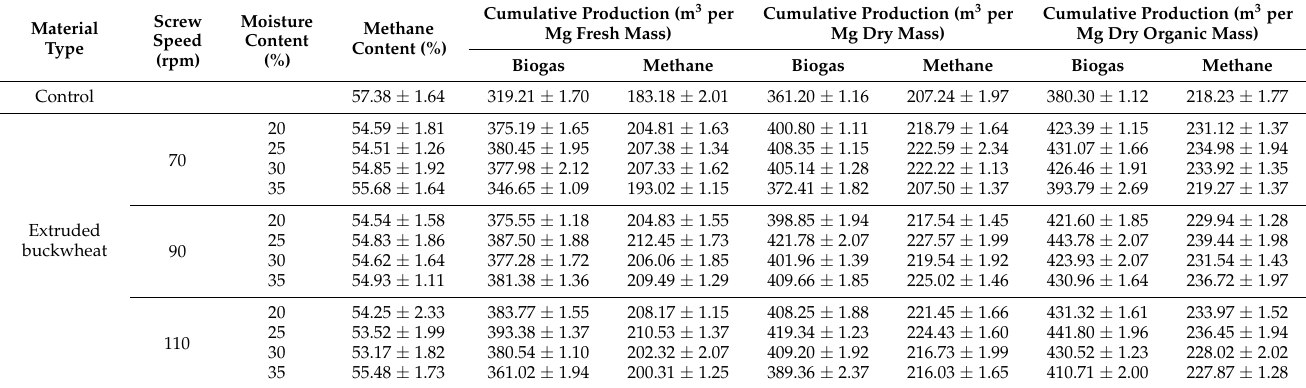
Table 9. Biogas efficiency of extruded buckwheat straw (after modification of the extruder screw; ±